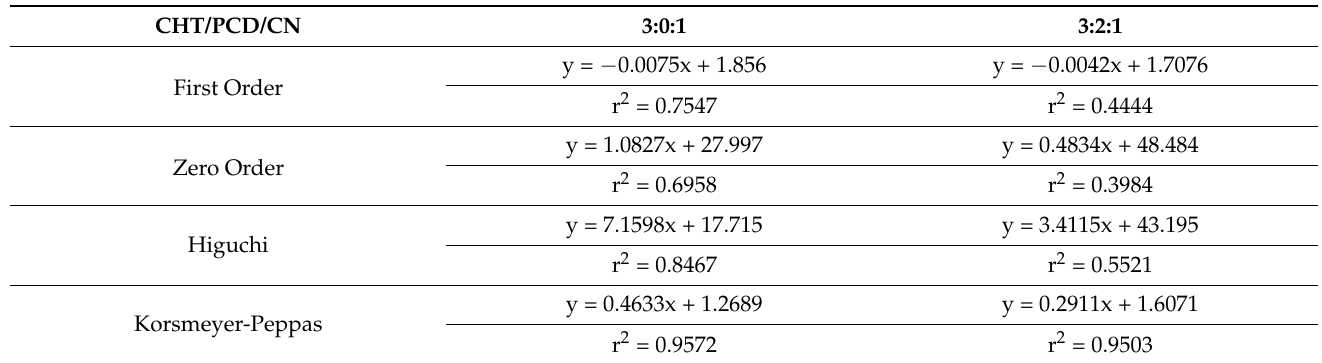
Table 4. Linear equations and determination coefficients of the First Order, Zero Order, Higuchi, and Kosmeyer-Peppas models applied to the average data obtained from the release study under dynamic flow conditions.